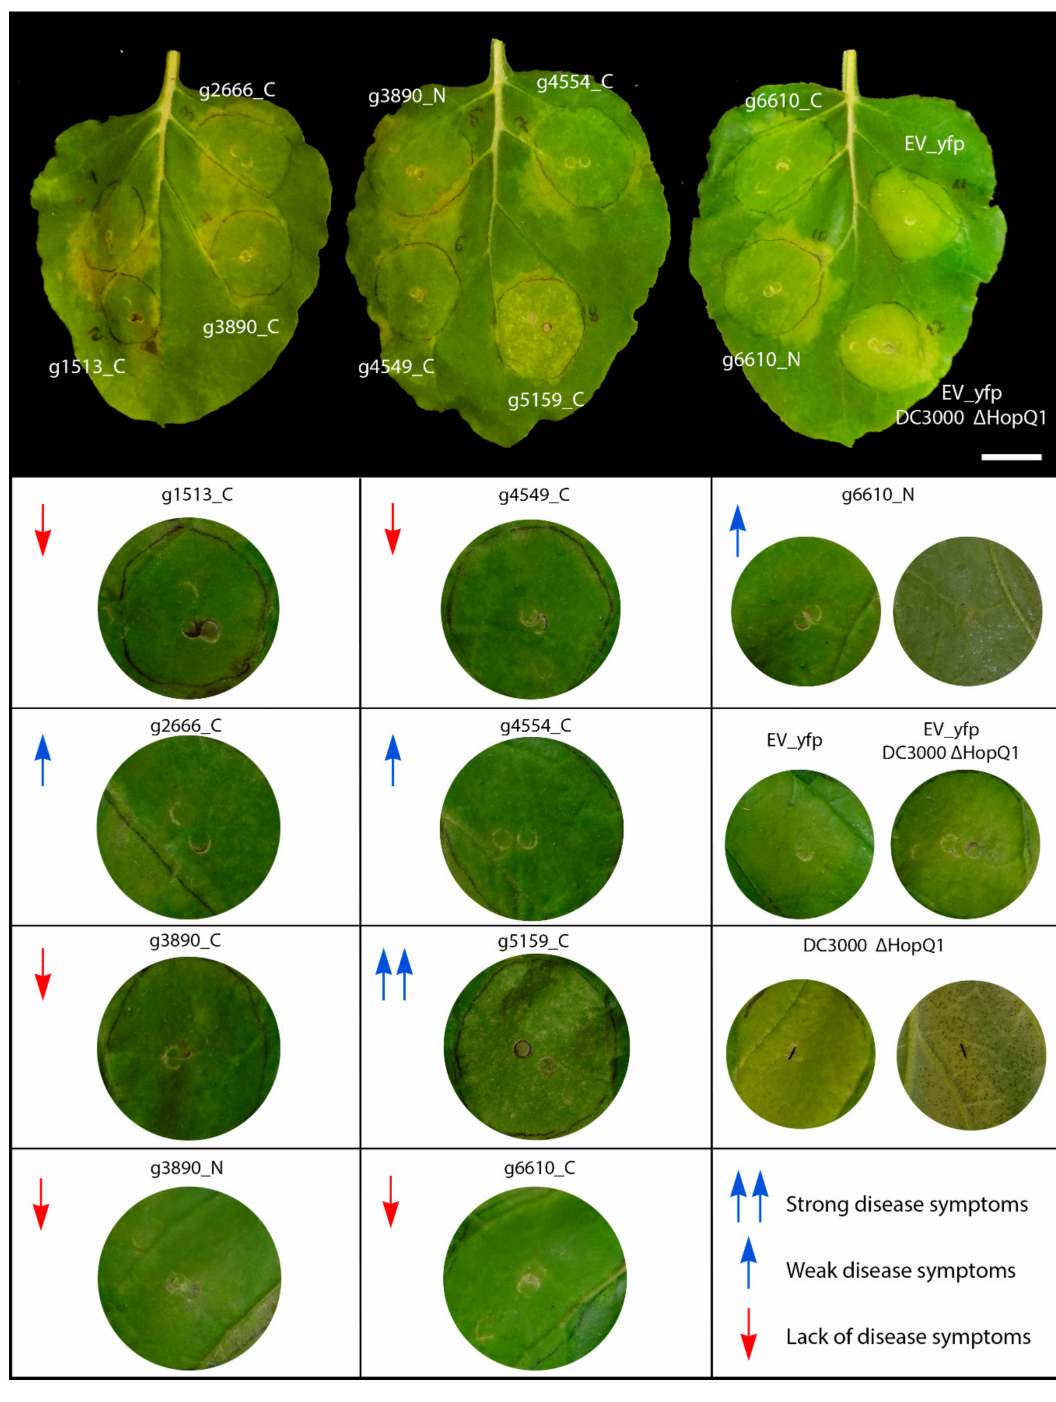
Figure 4. Virulence assay. The assay was conducted by the inoculation of Pst DC3000 ∆ HopQ1-1 mutant over S. scitamineum candidate e ff ector proteins expressed by agroinfiltration. Di ff erent levels of disease symptoms were observed. Red down arrows mean lack of disease symptoms, blue up arrows weak disease symptoms and double blue up arrows strong disease symptoms. Bar: 2.5